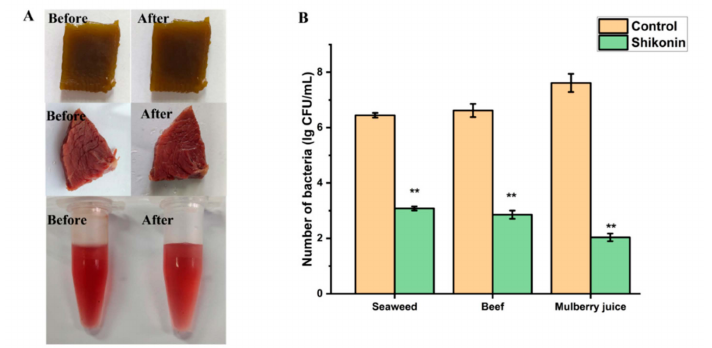
Figure 11. The application of shikonin in food. ( A ) The sensory morphology of food before and after shikonin treatment; ( B ) Shikonin inhibits the proliferation of S. aureus in food. ** p <